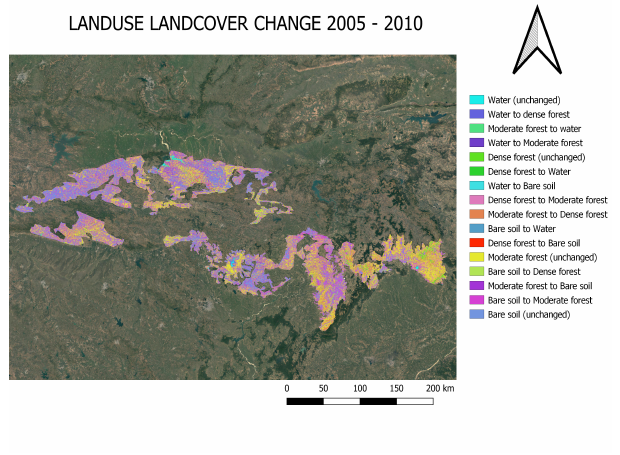
Figure 8: LULC Change 2005 - 2010 range. The coal reserves and coal blocks in the study area clearly represent the massive energy sector coal fields have turned into. Most of the Natural gas pipelines (NGP) and Petroleum products pipelines (PPP) passes through the sensitive area surrounding the protected forest cover landscape. Figure 14, talks about the Potential habitat connectivity for tiger movement between tiger reserves and Maharashtra- Madhya Pradesh corridor as depicted by CIRCUITS-CAPE model that helps to monitor the change in the tiger movements and their habitat